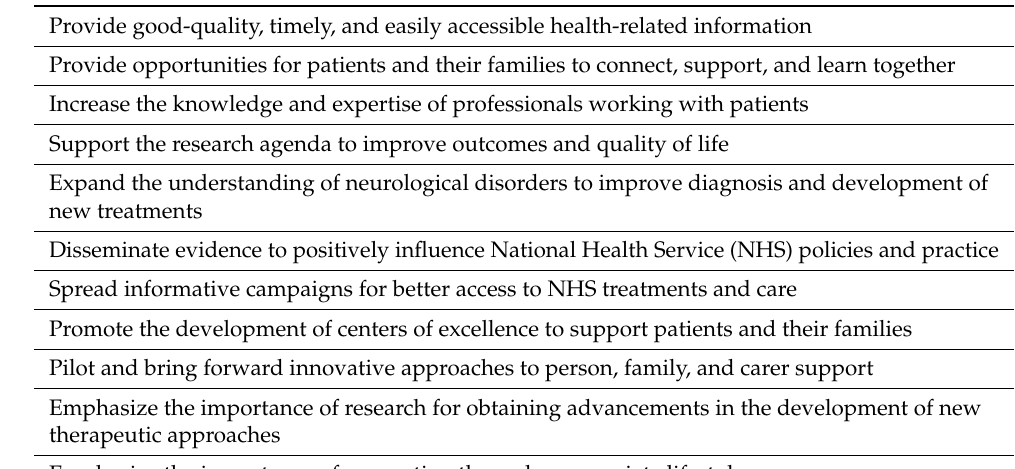
Table 2. Identified aims of public engagement for neurological